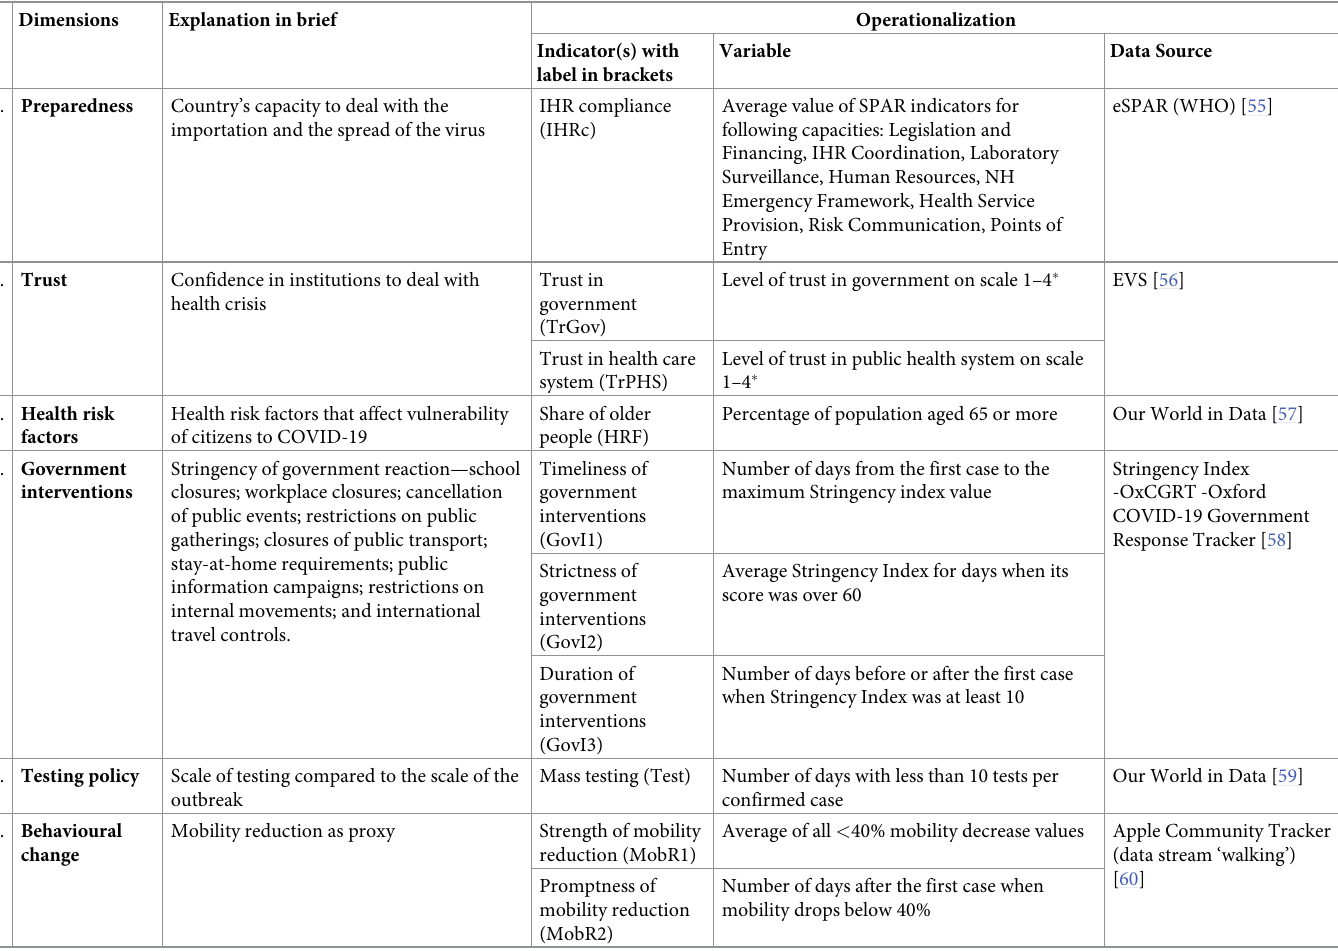
Table 2. Operationalisation of